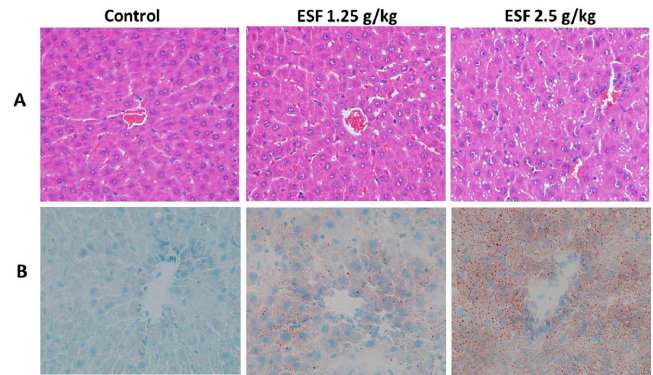
Figure 2. Effect of extract of Sophora flavescens on biochemical parameters in male rats for 2 weeks. ALT, Alanine aminotransferase; AST, Aspartate transaminase; TBIL, total bilirubin; ALP, alkaline phosphatase; TG, Triglyceride; CHOL, total cholesterol. * p < 0.05, ** p < 0.01, *** p < 0.001 versus vehicle-treated group.